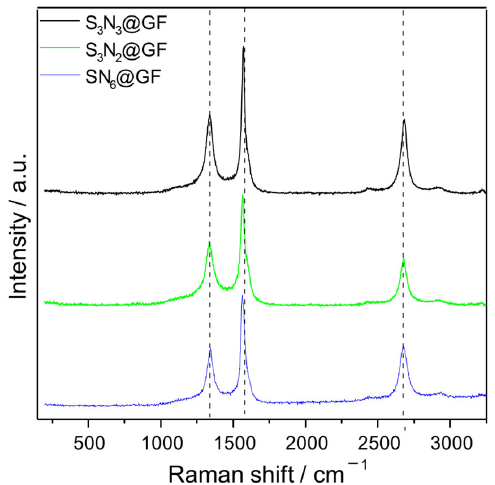
Figure 2. Raman spectra of S 3 N 3 − GF (black), S 3 N 2 − GF (green), and SN 6 − GF (blue).